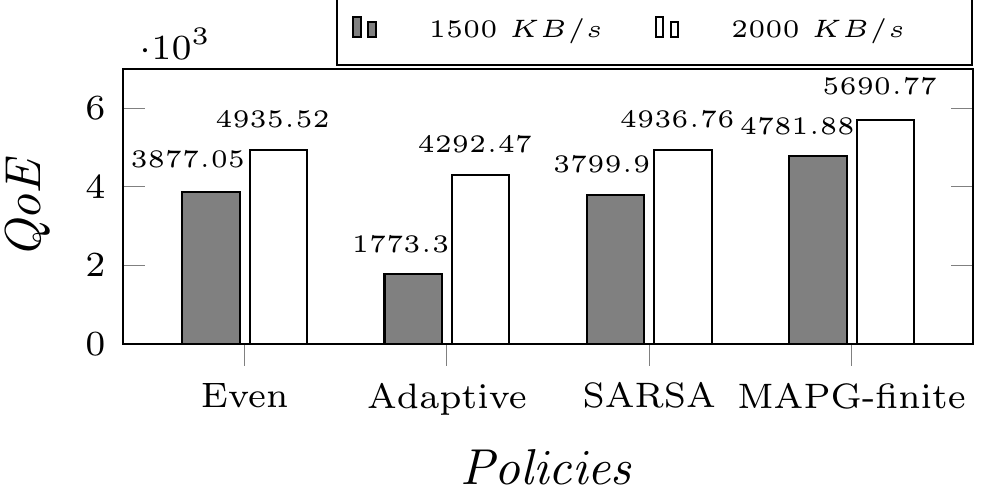
Figure 6. The QoE reward comparison. With the 1500 KB/s download link, MAPG-finite outperforms “Even” by 23.34%, “Adaptive” by 169.66%, and SARSA by 25.84%. With the 2000 KB/s download link, MAPG-finite outperforms “Even” by 15.30%, “Adaptive” by 32.58%, and SARSA by 15.27%.